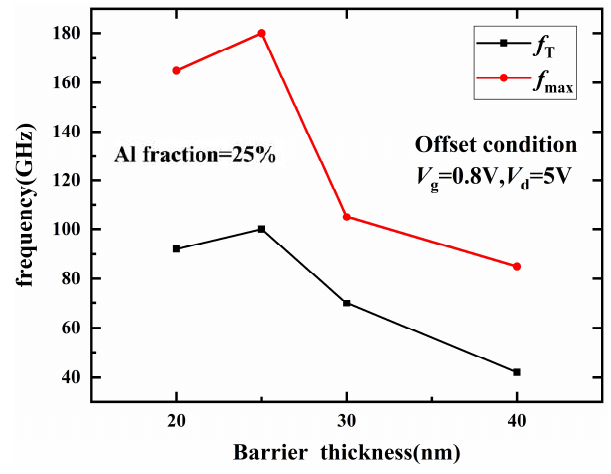
Figure 5. Effect of barrier thickness on f t and f max .